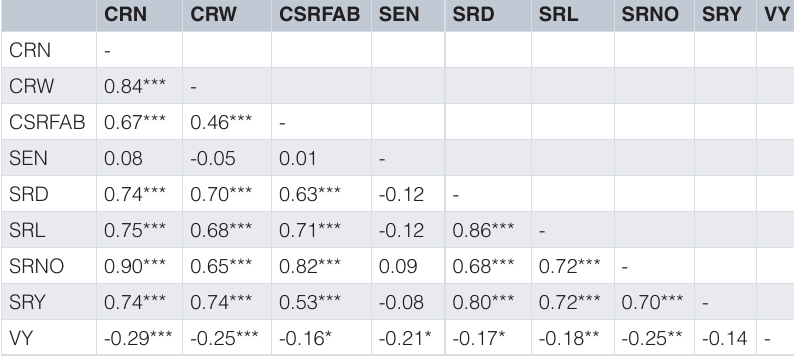
Table 8. Pearson’s correlation coefficients of CRN, CRW, CSRFAB, HI, SEN, SRD, SRL, SRY, VW and VY for 130 sweetpotato genotypes across two locations (Namulonge and Serere) and two seasons (2016B and 2017A) (N = 4160).